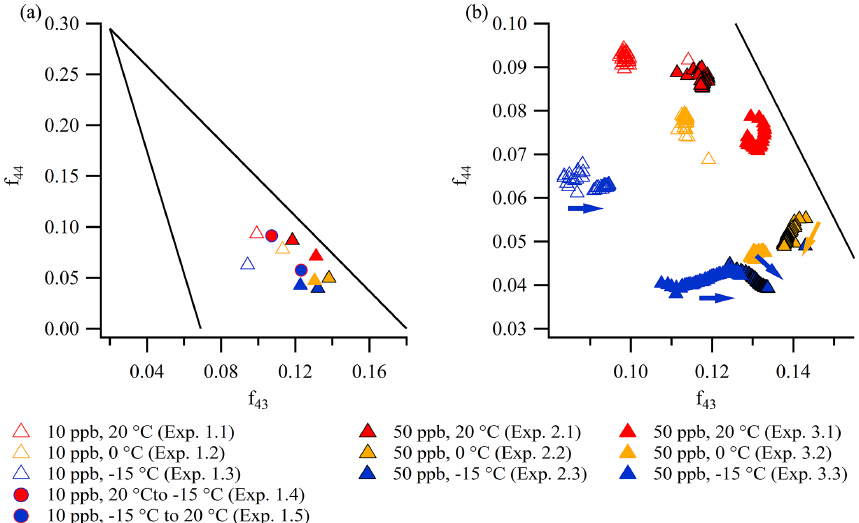
Figure 6. The elemental composition of particles formed in experiments 1.1–1.3, 2.1–2.3, and 3.1–3.3 depicted in triangle plots ( f 44 vs. f 43 ) (a) at the mass peak (five-data-point average) and in the expansion (b) during the experiments ( ∼ 5min time resolution, arrows indicate the direction of time). Note the different scales of the axes in panels (a) and (b) . In the triangle plots, the lines ( y = − 6 . 0204 x + 0 . 4154 and y = − 1 . 8438 x + 0 . 3319, where 0 . 069 ≤ x ≤ 0 . 18 and y ≤ 0.295) define the common composition of oxygenated organic aerosol (Ng et al.,